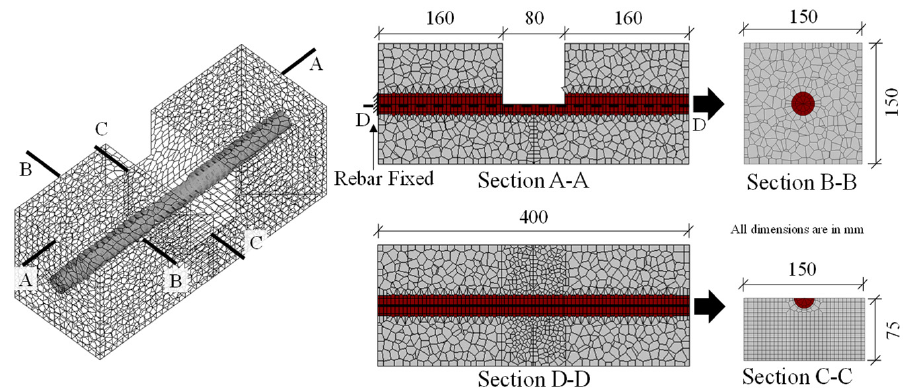
Figure 6. Geometry of model with window and notch in 3D RBSM. Table 1. Input material properties.